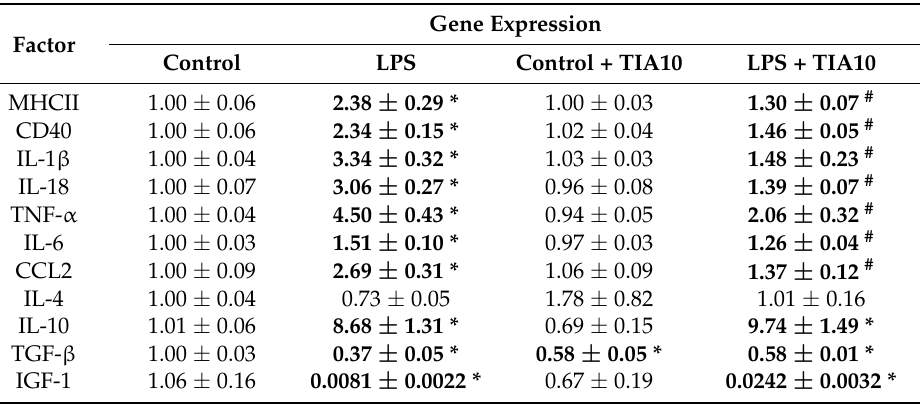
Table 1. The effect of tianeptine (TIA) on microglia activation markers (major histocompatibility complex class II (MHC II) and cluster of differentiation 40 (CD40)), pro-inflammatory factors (interleukin (IL)-1 β , IL-18, tumor necrosis factor alpha (TNF- α ), IL-6, and chemokine CC motif ligand 2 (CCL2)) and anti-inflammatory factors (IL-4, IL-10, transforming growth factor (TGF- β ), and insulin-like growth factor 1 (IGF-1)), measured using qRT-PCR in vehicle- and lipopolysaccharide (LPS)-treated primary microglial cells. Microglial cells were pretreated with tianeptine (TIA; 10 µ M) for 30 min, and then with lipopolysaccharide (LPS; 100 ng/mL). The data are presented as an average fold ± standard error of the mean (SEM) from independent experiments. The results were statistically evaluated using two-way analysis of variance (ANOVA) with a Duncan post-hoc test to assess the differences between the treatment groups. Significant differences from the control group (vehicle-treated cells) are indicated by * p < 0.05; differences between LPS-treated groups and pre-treated with tianeptine and then stimulated with LPS groups are indicated by # p < 0.05. The bold data shows statistically significant